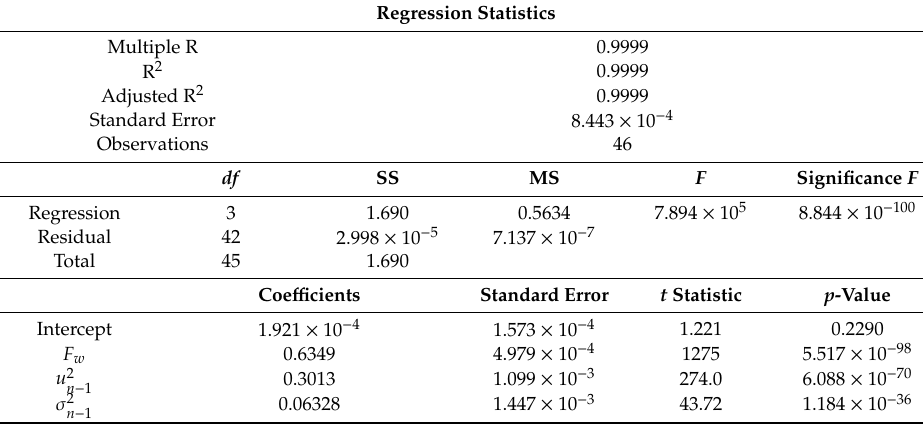
Table 7. Analysis of the vanilla production